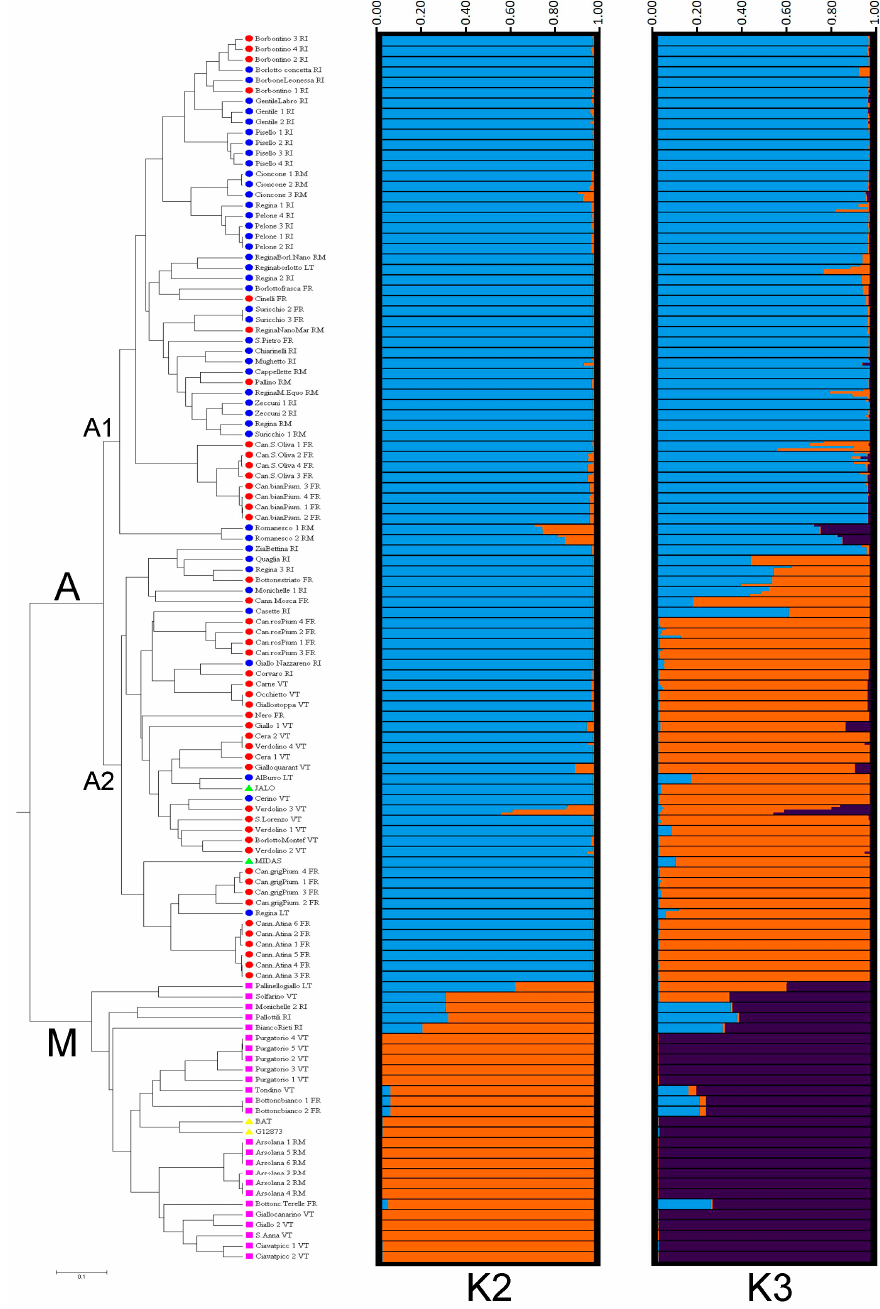
Figure 5. UPGMA tree based on Nei’s coefficient [59] among the 114 accessions belonging to the 66 P. vulgaris landraces from the Lazio region. Structure bar plots of average proportions of membership for K = 2 (in blue and orange) and K = 3 (in blue, orange, and dark violet) clusters are given for the four genotypes of each of the 114 accessions studied. In the phylogenetic tree, the blue and red circles and the pink square indicate the landraces with C, T, and S PHAS types, respectively. The genotypes BAT and G12873 of Mesoamerican origin (yellow triangles) and MIDAS and JALO of Andean origin (green triangles) were included as